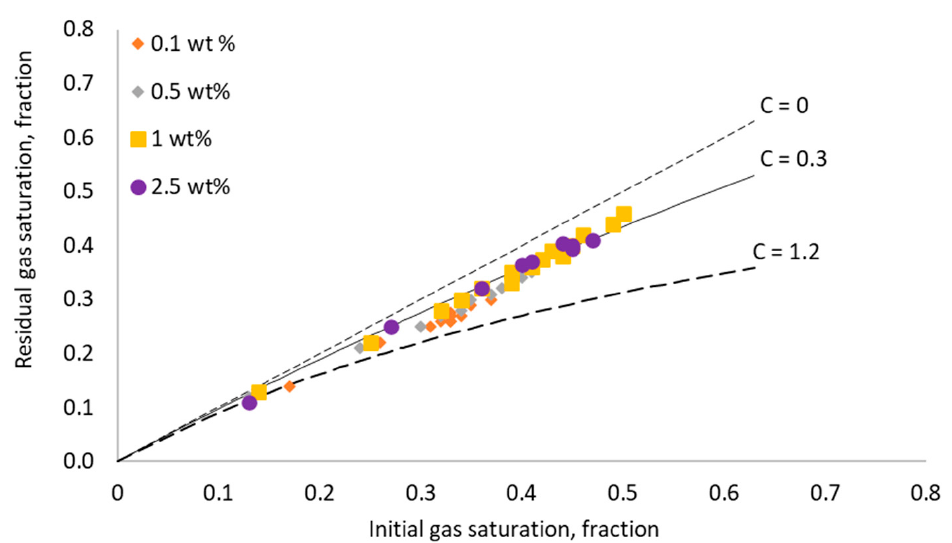
Figure 10. Initial–residual saturation curves of the AC sample under SAG injection conducted with various surfactant concentrations. The solid and dashed lines show Land’s model fitting using various values of the C coefficients.